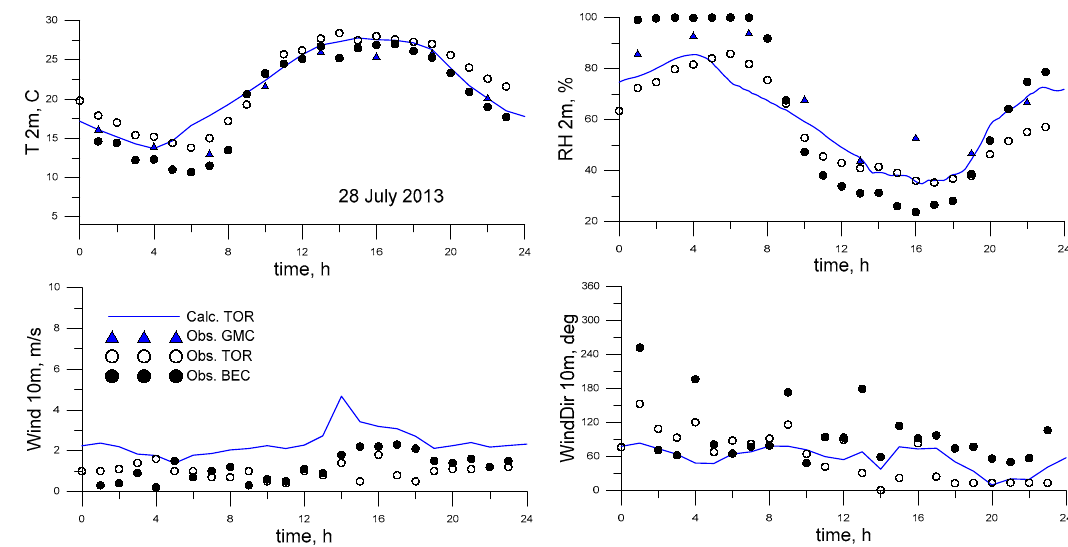
Figure 2. Calculated and measured near ground meteorological values at the observation sites. The blue lines are the results of numerical prediction at the TOR station and symbols are observation data (open circles—TOR, closed circles—BEC, triangles—GMC).